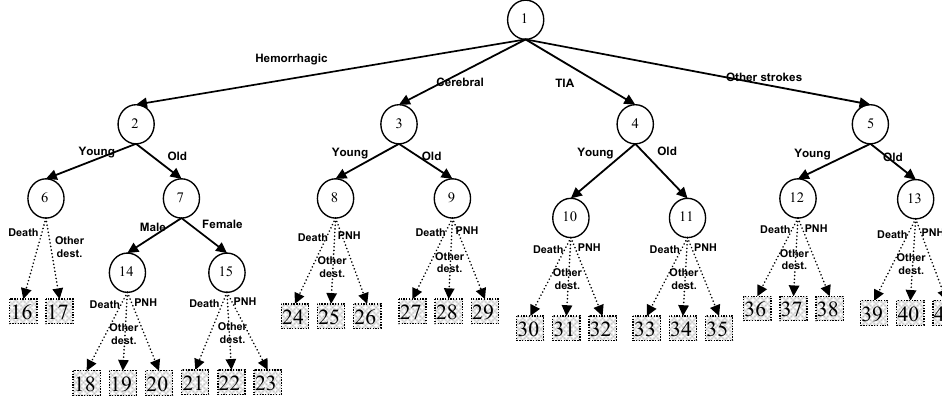
Figure 3. EPHTST constructed using the WIC ‐ based splitting criterion. Table 2. Tree extension using the WIC ‐ based splitting criteria (nodes and possible splits by the co ‐ variate discharge destination).